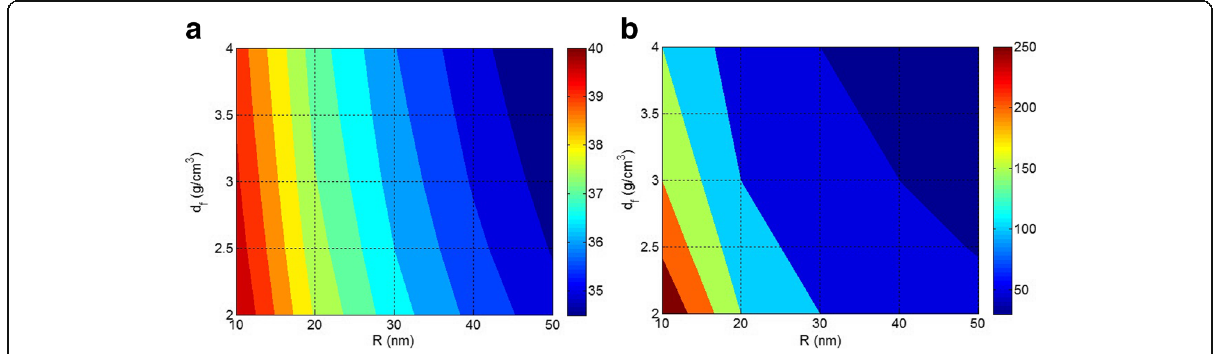
Fig. 2 Contour plots to show the roles of R and d f parameters in a ln ( N ) and b A (m 2 ) at W f = 2 g